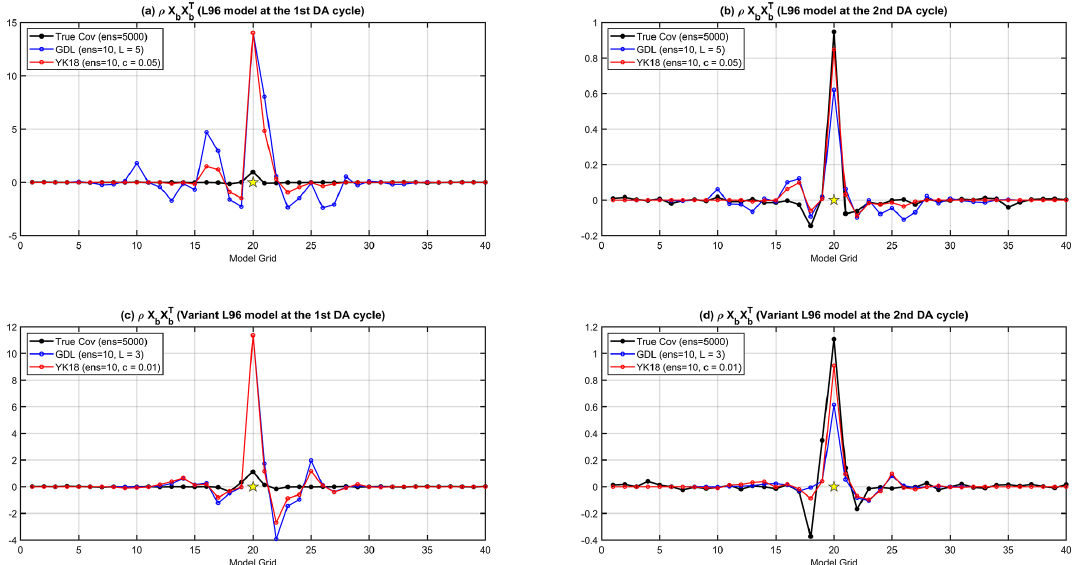
) of GDL (blue) and YK18 (red) for the L96 model at (a) the b